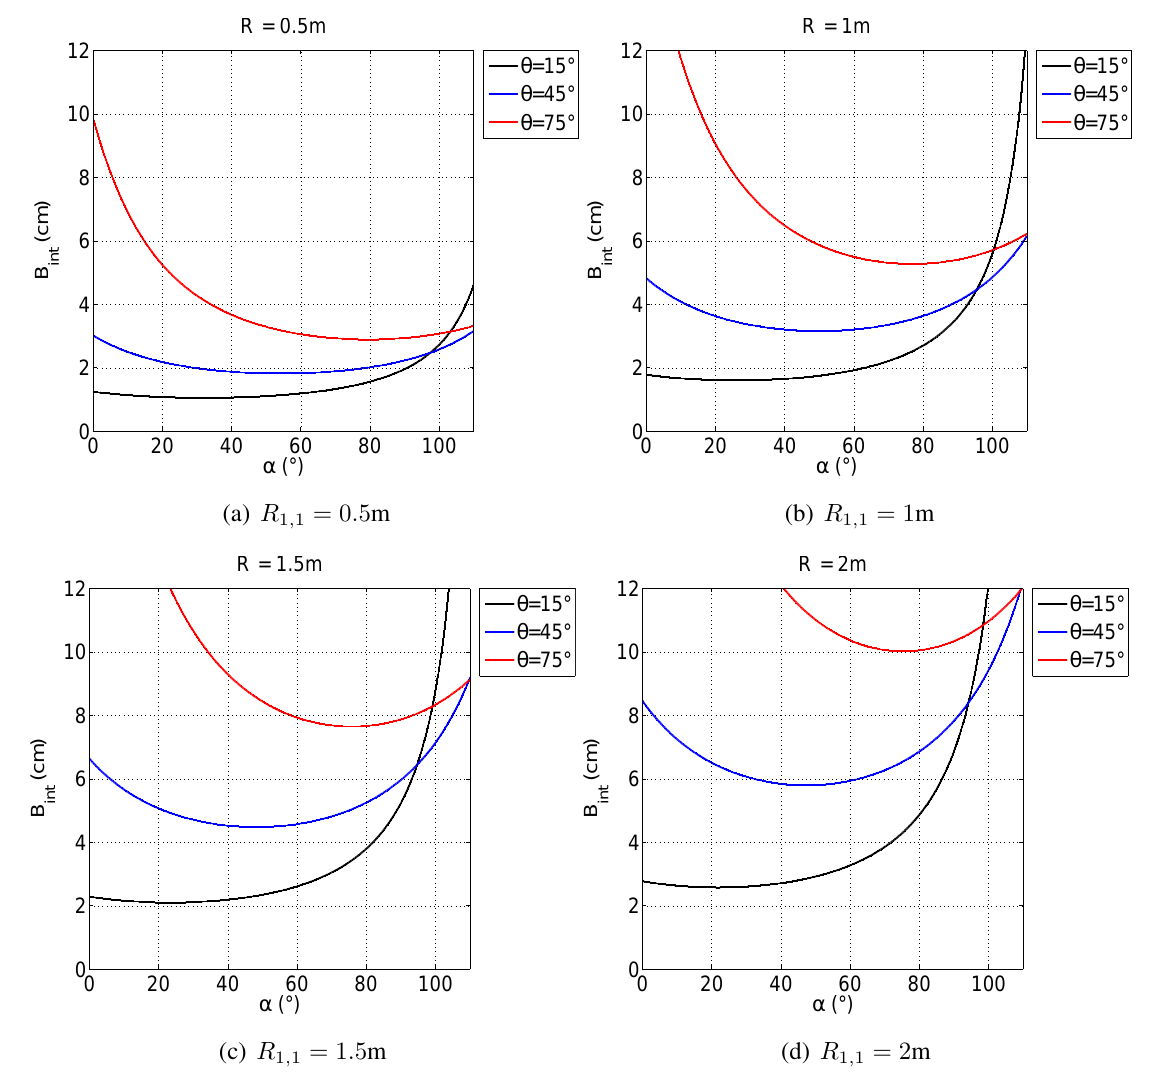
Figure 7. Critical baseline for various operating conditions. For each plot, dr = 10 cm and ∆ h = 10 cm have been